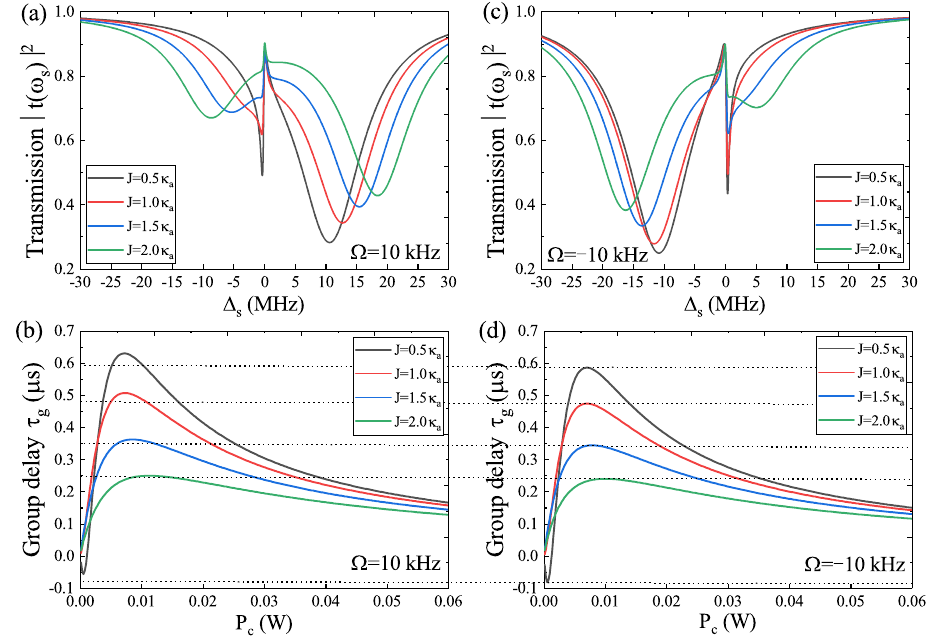
Figure 4. ( a , b ) The transmission T ( ω s ) and the group delay τ g for different cavity–cavity coupling J in condition of Ω = 10 kHz. ( c , d ) The transmission T ( ω s ) and the group delay τ g for different cavity–cavity coupling J in condition of Ω = − 10